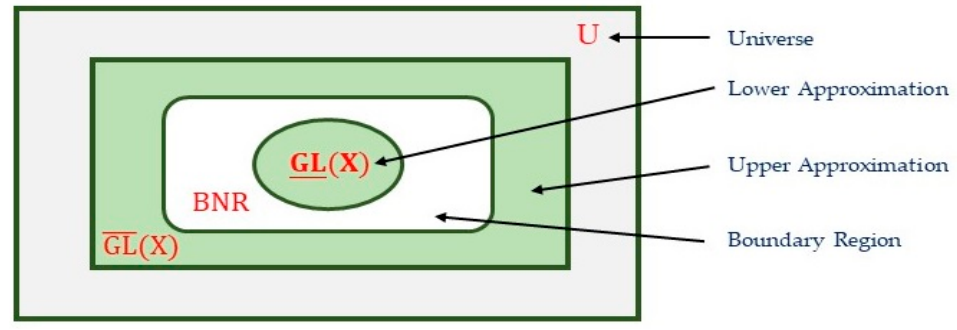
Figure 2. Proposed clustering stages.